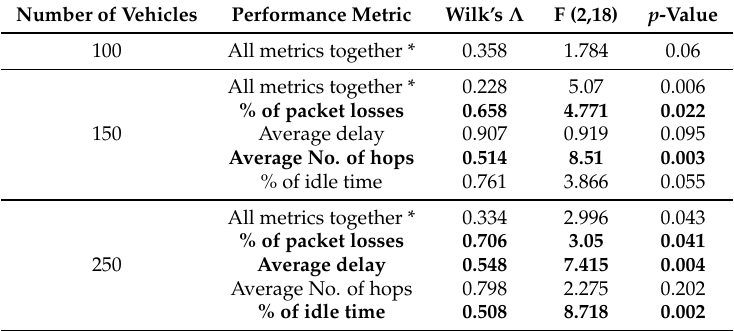
Table 5. MANOVA [37] results for the interaction test among recovery techniques ( RT ) and the forwarding technique ( FT ) for the recovery phase of GHR. * Degrees of freedom in the F statistic are 8 and 12. If there is a significant interaction ( p- value < 0.05) in the “all metrics together” test, then interaction tests per metric need to be performed.